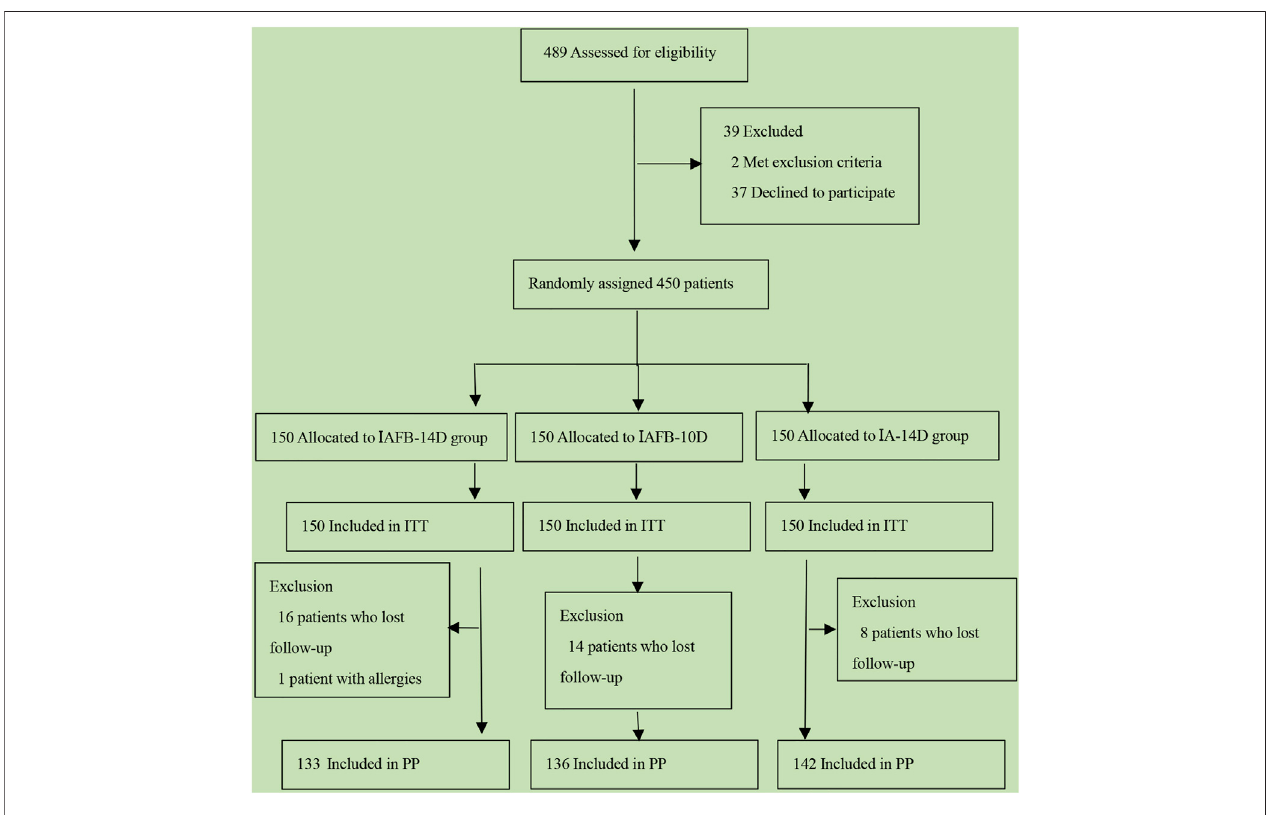
FIGURE 1 | Flowchart of this study.